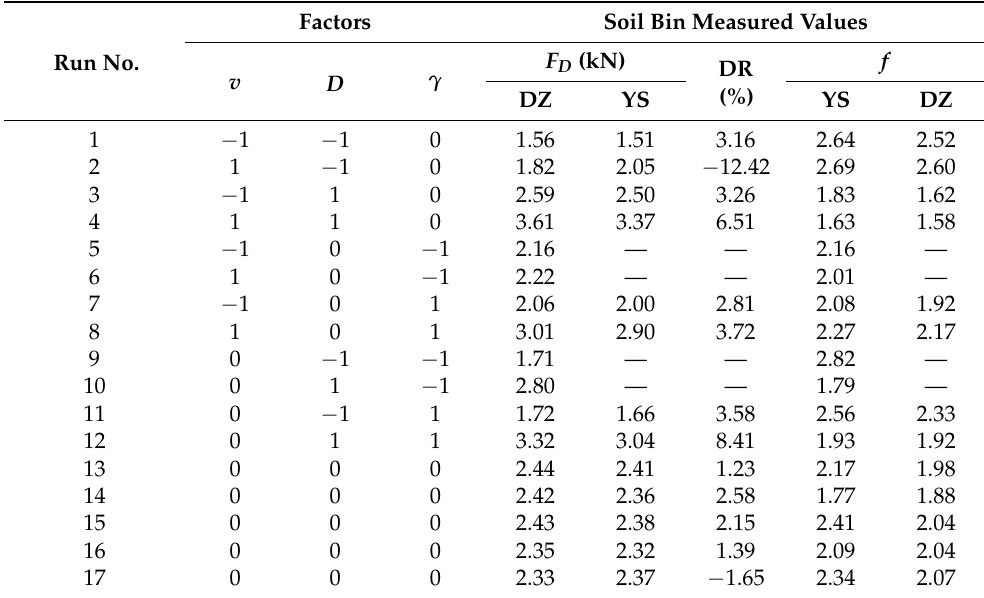
Table 7. Experiment scheme and measured results for single shovels in soil bin experiments.